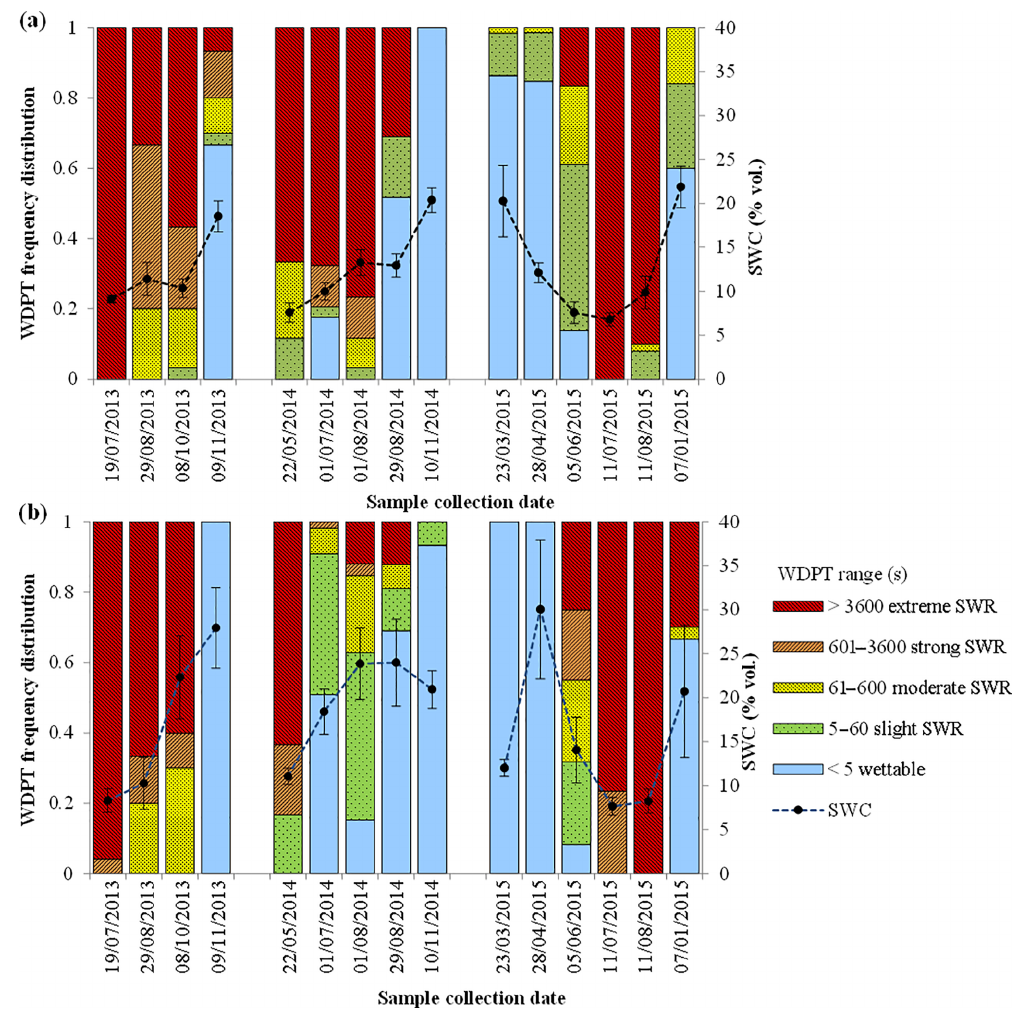
Figure 3. Frequency distribution of soil water repellency (SWR) persistence, measured as water drop penetration time (WDPT) and soil water content (SWC) for (a) forest and (b) grassland site at 0–9cm depth at all sampling dates. Different colours reflect WDPT classes, black circles represent mean SWC and error bars the SD of the mean ( n = 120 per